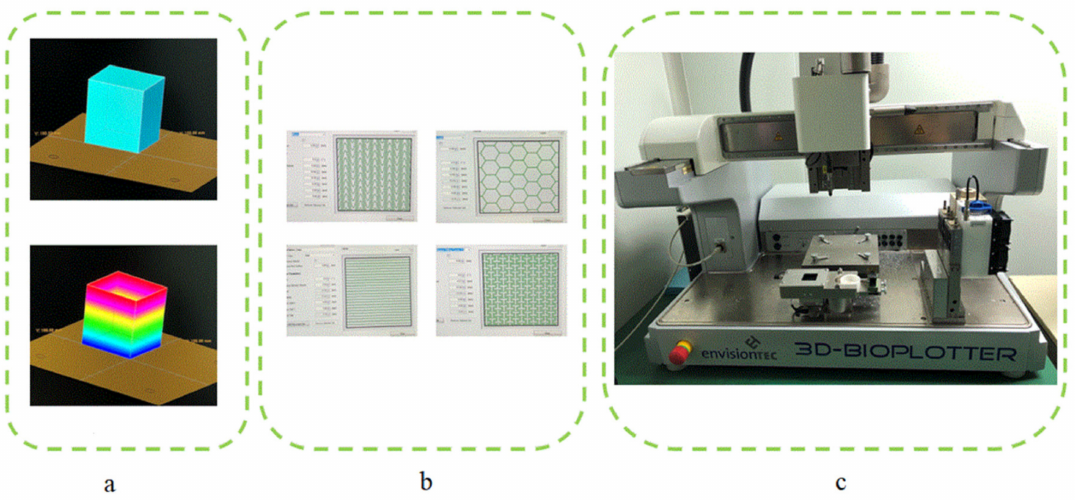
Figure 2. Sca ff old printing process. ( a ) CAD model construction and sliced layers generation; ( b ) Di ff erent pattern assigned before printing; ( c )